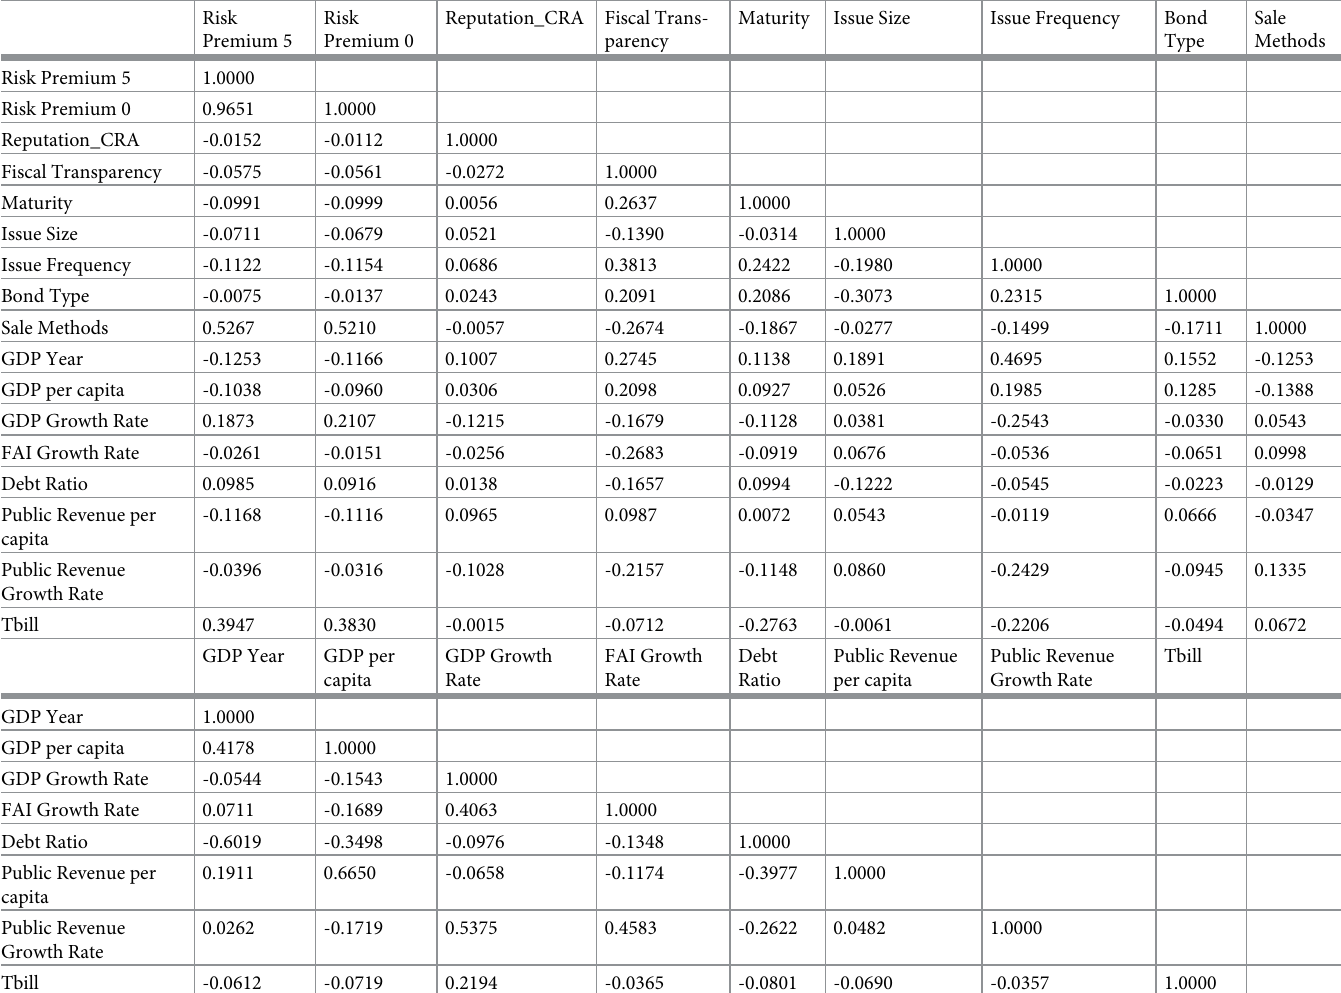
Table 6. Correlation matrix. This table presents the correlation matrix of the